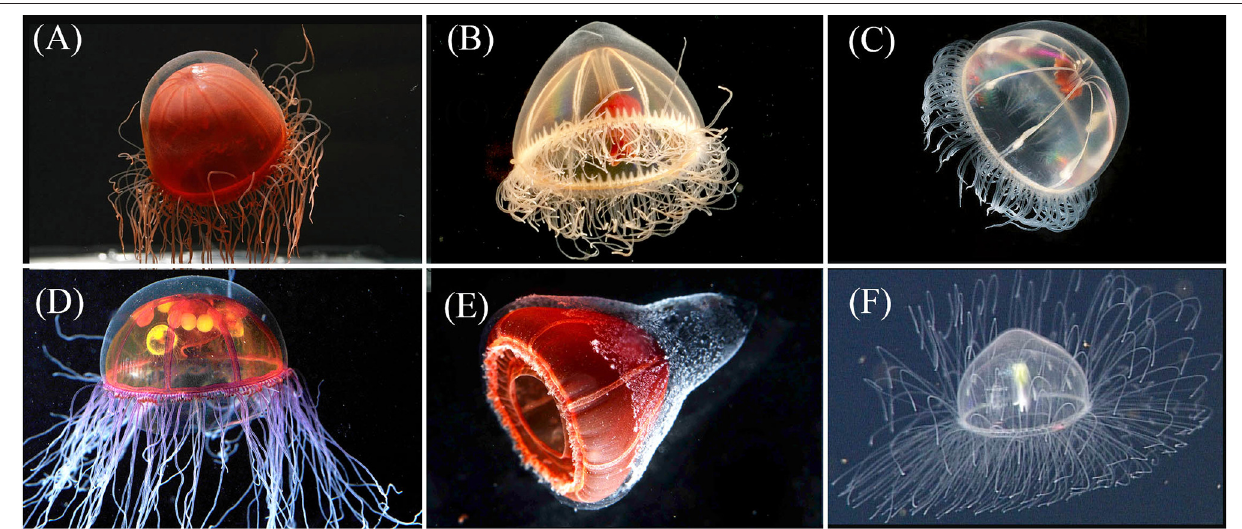
FIGURE 3 | Row 1: The exumbrella of Crossota norvegica [ (A) —photo by K. Raskoff from 1,595m in the Chukchi Basin, Arctic] appears more transparent than its congeners. Pectis tatsunoko [ (B) —T1024SS11 from 1,028m in Astoria Canyon, Oregon] has eight centripetal canals, often irregular in height along each quadrant and are more hemispherical in shape than Benthocodon hyalinus [ (C) —photo by K. Raskoff, from 635m along the Northwind Ridge, Arctic]. Note the presence of a mostly clear peduncle and red lips in both P. tatsunoko and B. hyalinus . Row 2 provides images of two additional species of Crossota that we have observed and were included in the molecular analysis: Crossota millsae [ (D) —DR88 @ 2,115m in Monterey Bay], Crossota n. sp. [ (E) —DR726 @ 2,292m in Mazatlan Basin, Gulf of California], and one that was not included in the molecular analysis Crossota alba [ (F) —DR723 @ 2,600m in Farallon Basin, Gulf of California]. Specimens (A) and (C) were collected in the Arctic *(Raskoff et al., 2010).